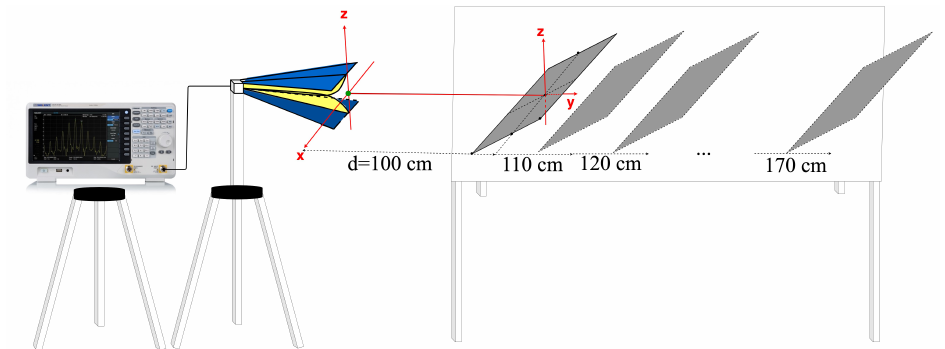
Figure 3. Proposed distance averaging technique.